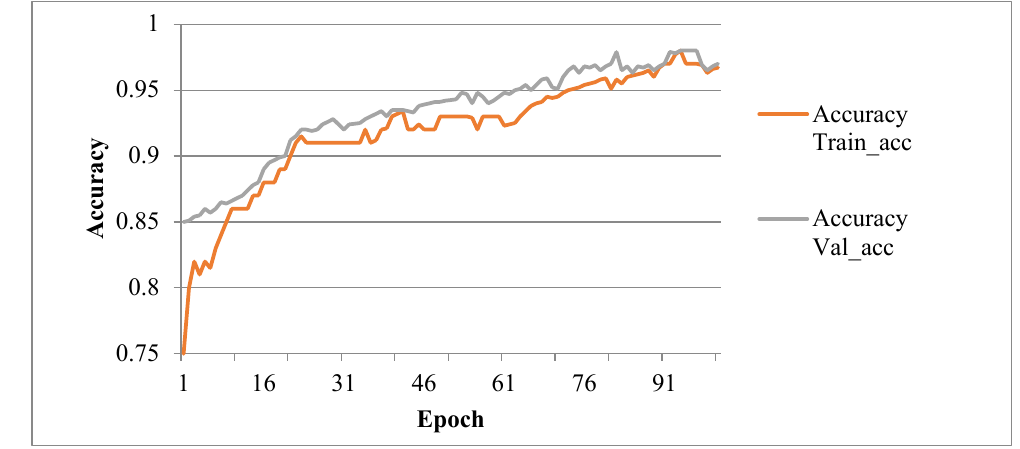
Figure 7. Accuracy Graph of Hybrid Convolutional Neural Network (Hy-CNN). Table 5. Accuracy table of Training and Testing with